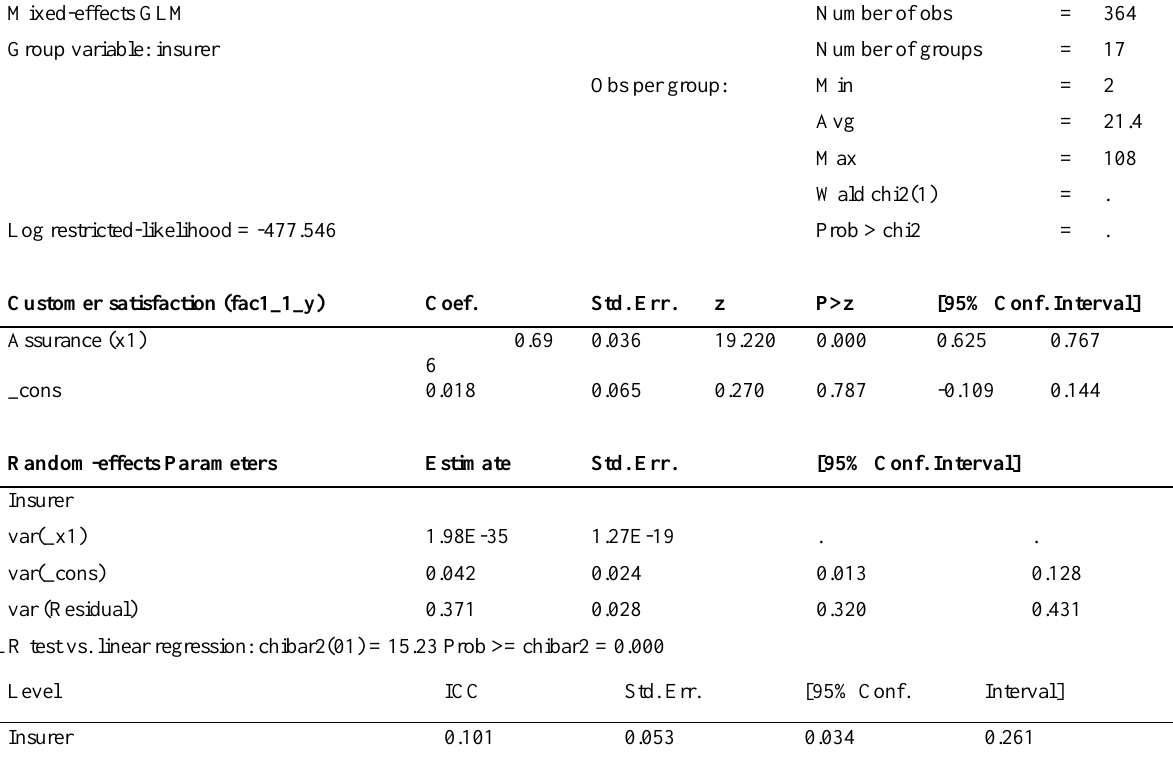
Table 5 : Effect of Assurance: fixed effect with random